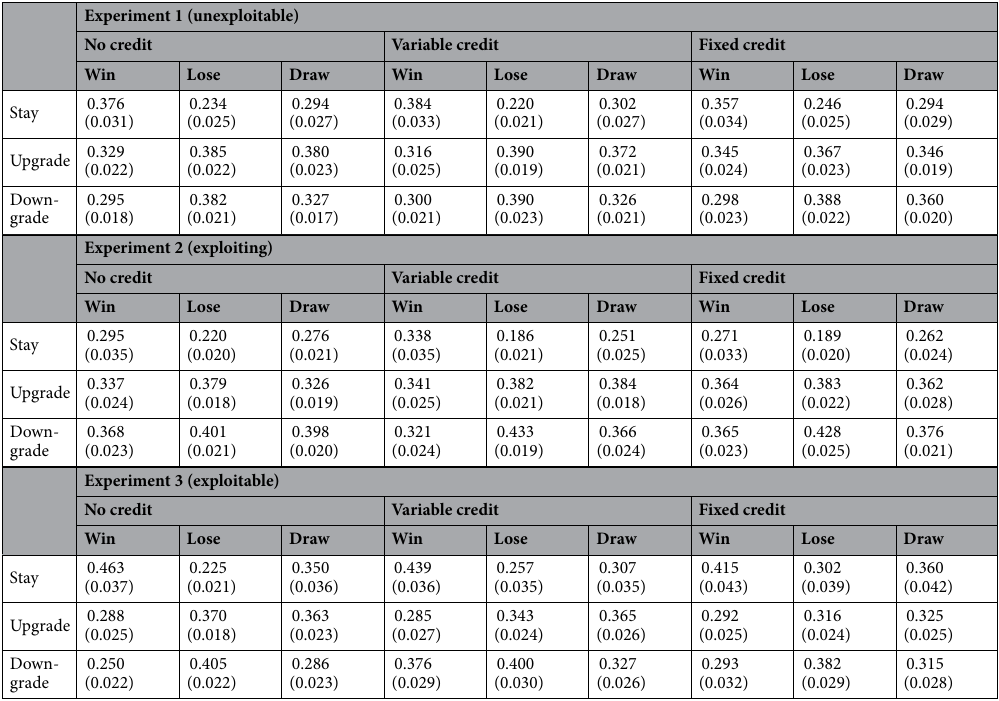
Table 2. Proportion of strategy at trial n + 1 ( sta y, upgrade [shift], downgrad e [shift]) relative to outcome at trial n (win, lose, draw) as a function of credit (no, variable, fixed) across Experiments 1–3. Standard error in